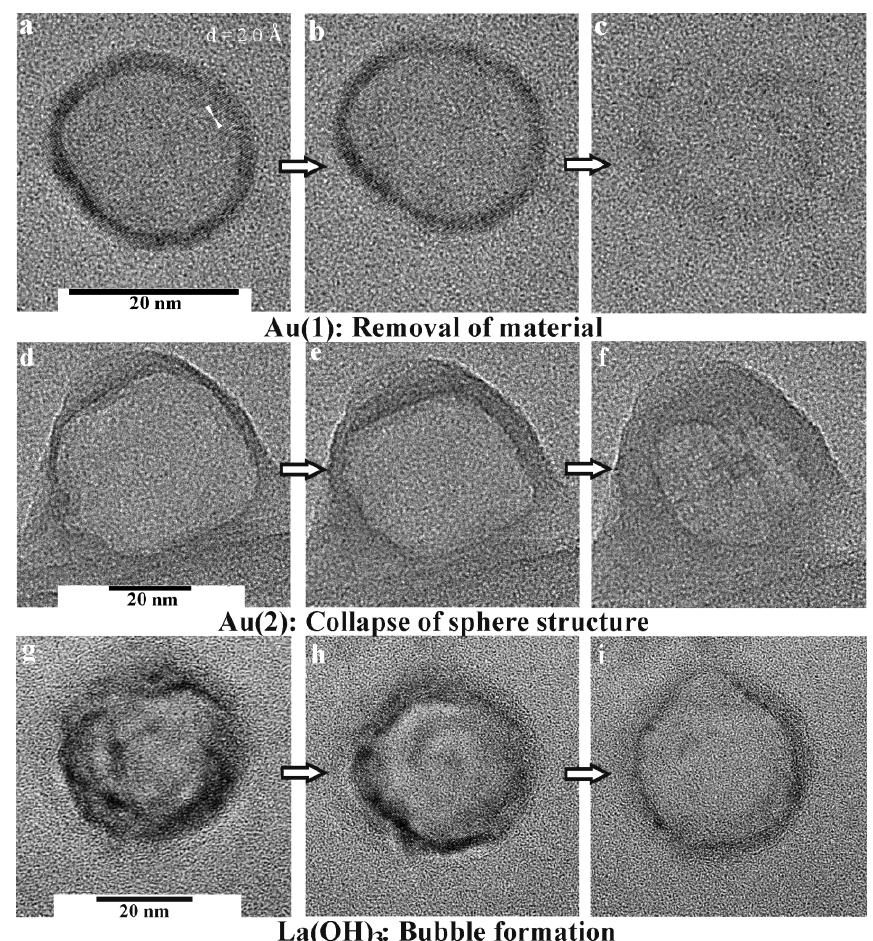
Figure 11. Destruction of hollow spheres under TEM conditions: a  c) Au, 15  20 nm in diameter; (d  f) Au, 40  60 nm in diameter; (g  i) La(OH) (modified reproduction from